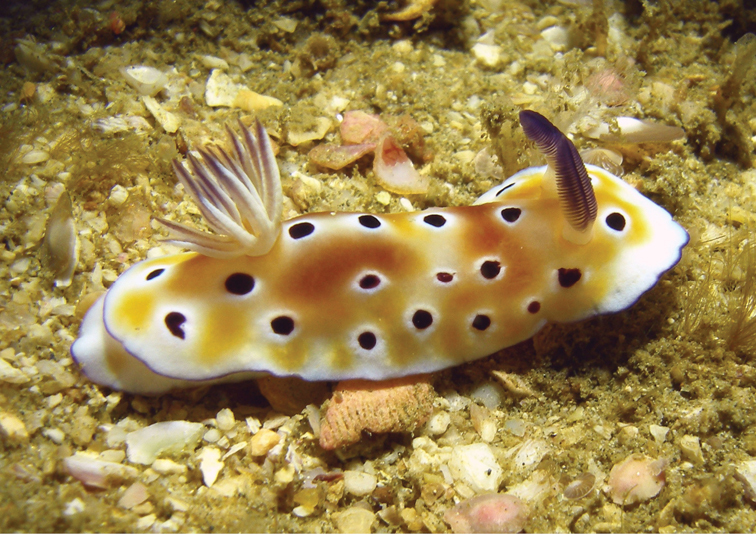
Chromodoris cavae, Sri Lanka, photo: S Kahlbrock (no spcm).